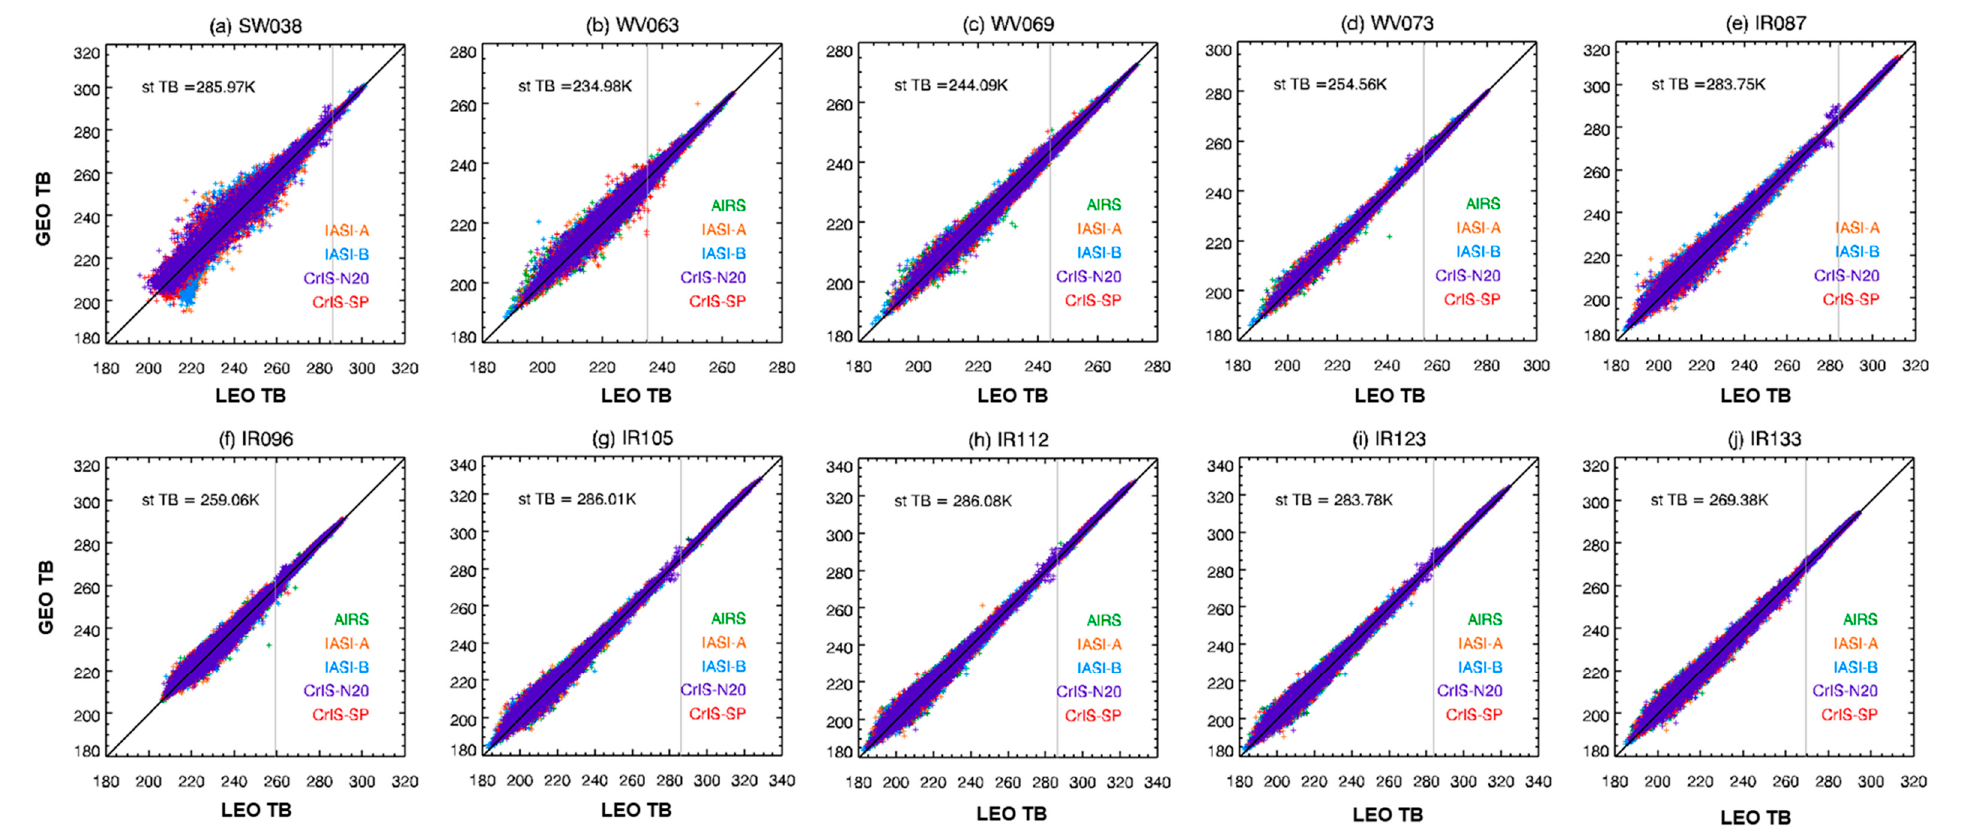
Figure 9. The scatter plot of Brightness Temperature (TB) from GK2A AMI and LEOs (infrared atmospheric sounding interferometer (IASI)-A (orange), IASI-B (blue), Atmospheric Infrared Sounder (AIRS) (green), Cross-track Infrared Sounder (CrIS)/NOAA-20 (purple), and CrIS/Suomi-PP (red)) for IR channel and grey line of standard scene TB. The period of the AMI data is from June 1 to September 30, 2019 (from July 23 for IR133). The statistics of the results are represented in Table 5.